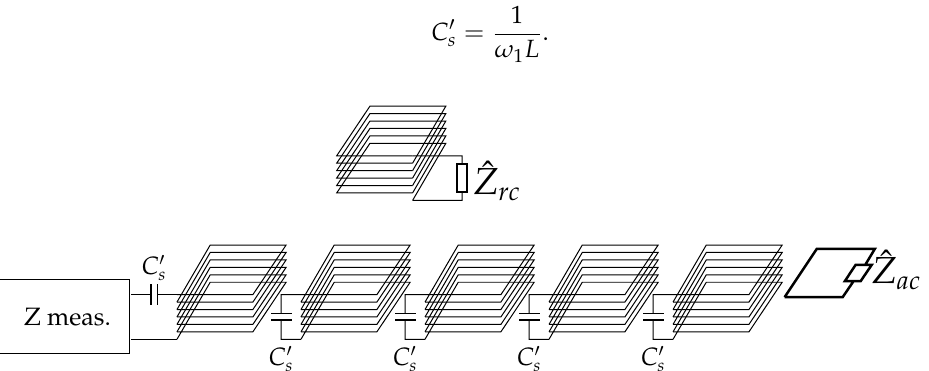
Figure 4. High-frequency equivalent circuit of the resonator array at ω 1 with an additional termina- tion coil (with ˆ Z acT ) and the receiver coil terminated on the impedance ˆ Z rc . The “Z measurement” block estimates the array input impedance as described in Section 4.3.